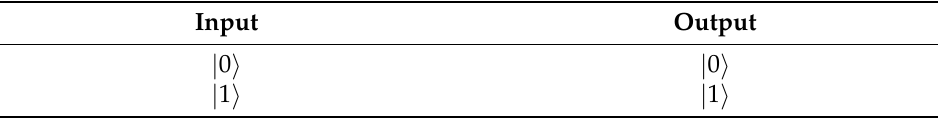
Table 1. Truth table of the Identity operation.